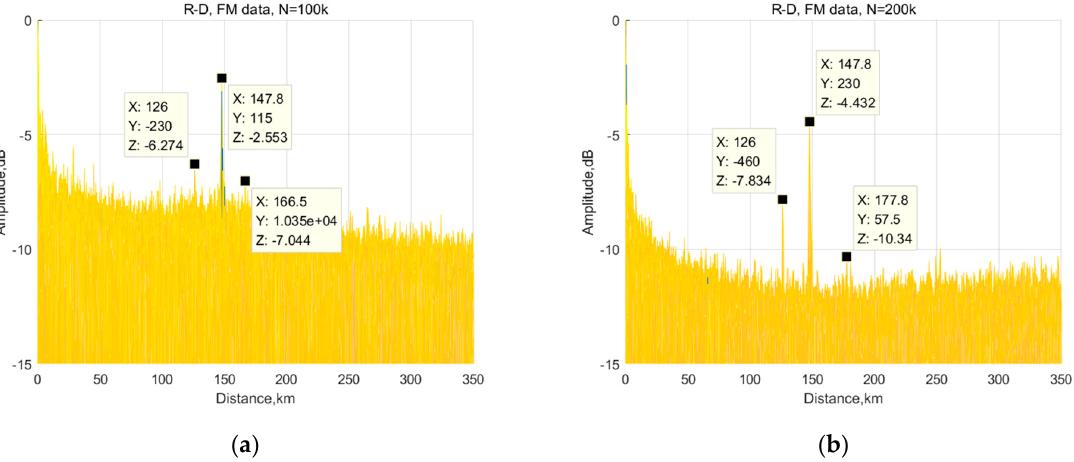
Figure 20. Integration results with traditional R-D processing for the FM signal: ( a ) N = 10 5 ; ( b ) N = 2 × 10 5 .